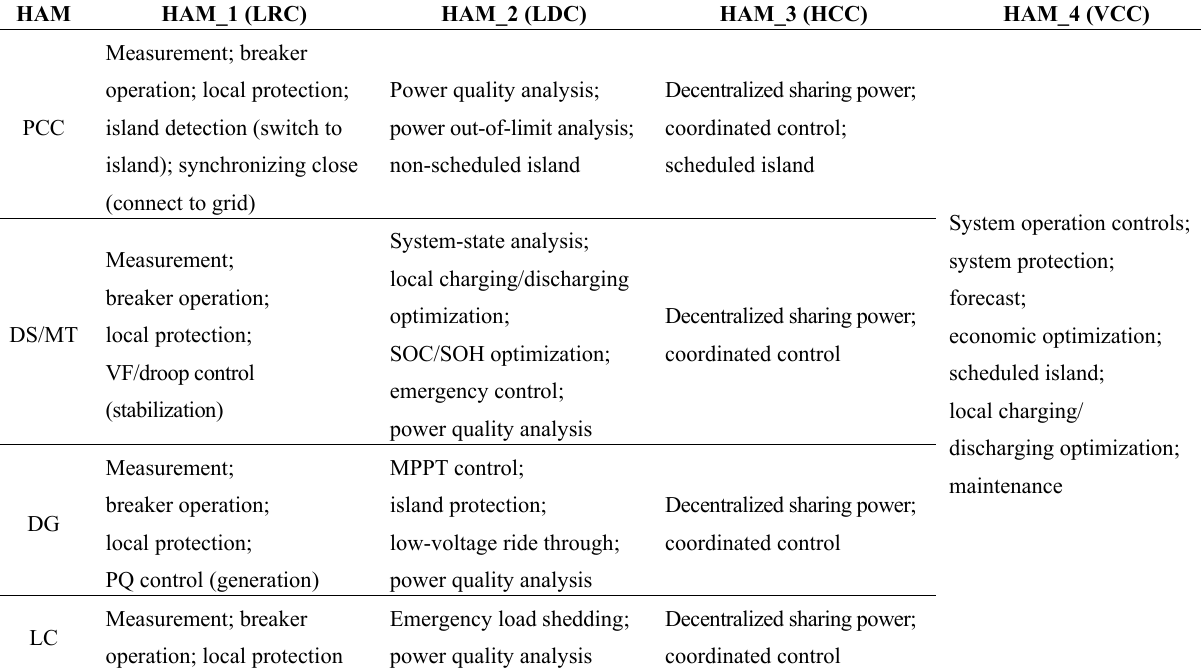
Table 1. Typical HAM in a microgrid. PCC: point of common coupling; DS: distributed energy storage; MT: micro-turbine; VF: voltage-frequency; SOC: state of charge; SOH: state of health; DG: distributed generator; PQ: active power and reactive power; MPPT: maximum power point tracking; and LC: load